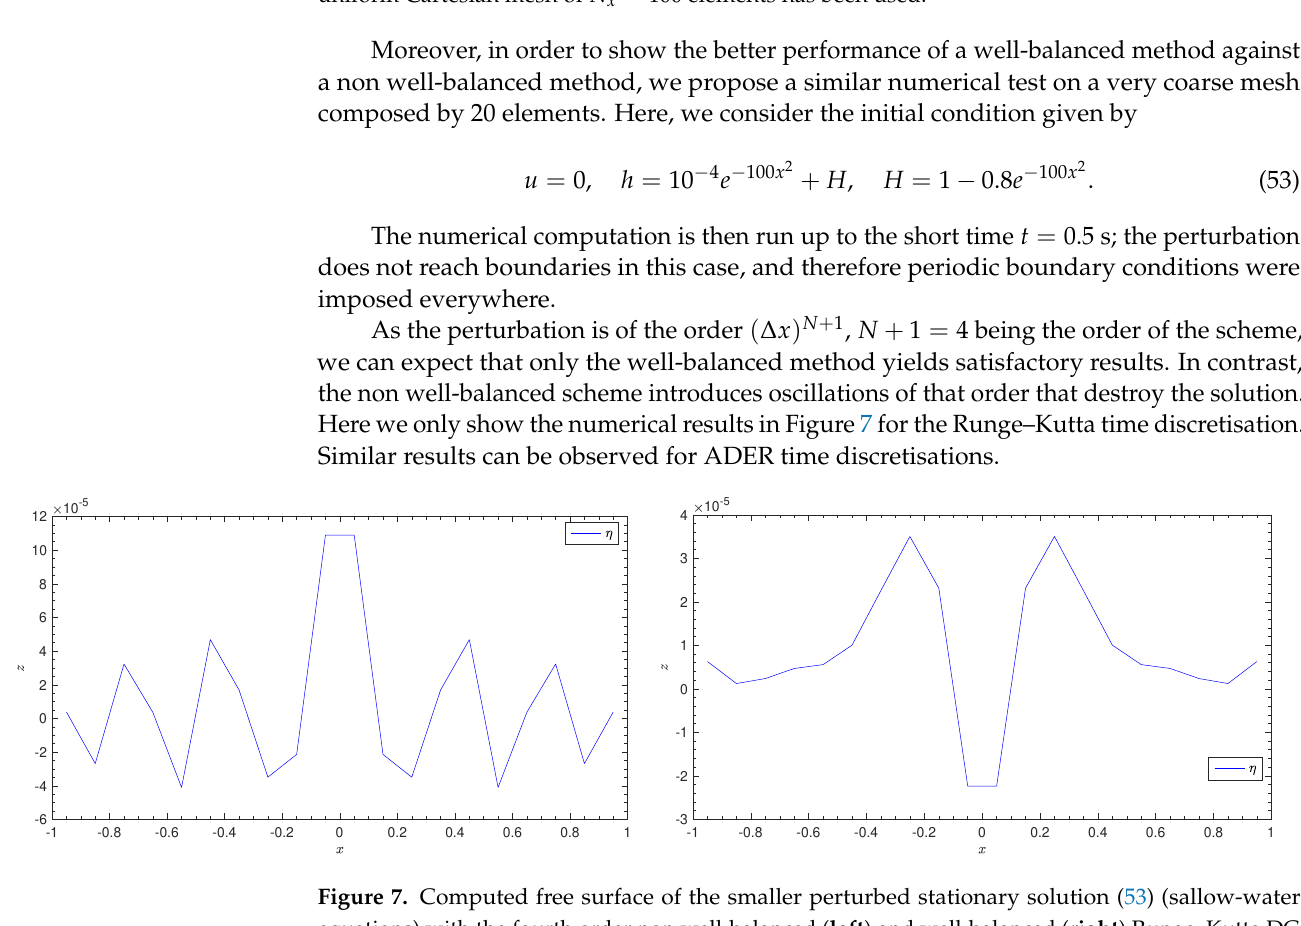
Figure 6. Computed free surface of the perturbed stationary solution (52) (sallow-water equations) with the fourth order well-balanced Runge–Kutta ( left ) and ADER ( right ) DG schemes at t = 10 s. A uniform Cartesian mesh of N x = 100 elements has been used.